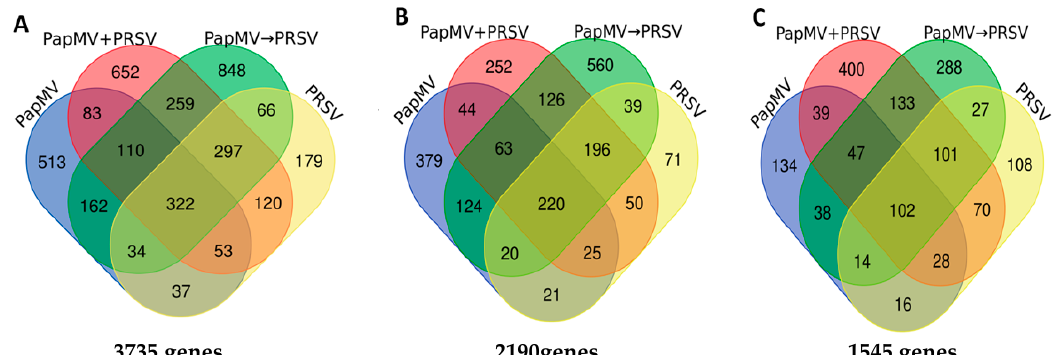
Figure 2. Differentially expressed genes (DEGs) on a Venn diagram for the single infections of PapMV and PRSV, and the stepwise infections of PapMV → PRSV (antagonism) and PapMV + PRSV (synergism). PapMV → PRSV (green), PapMV + PRSV (red), PapMV (blue), and PRSV (yellow). ( A ) Total DEGs (up- and downregulated). ( B ) Upregulated genes with ≥ 1.5 b (foldchange-like) values. ( C ) Downregulated genes with ≤− 1.5 b (foldchange-like) values.